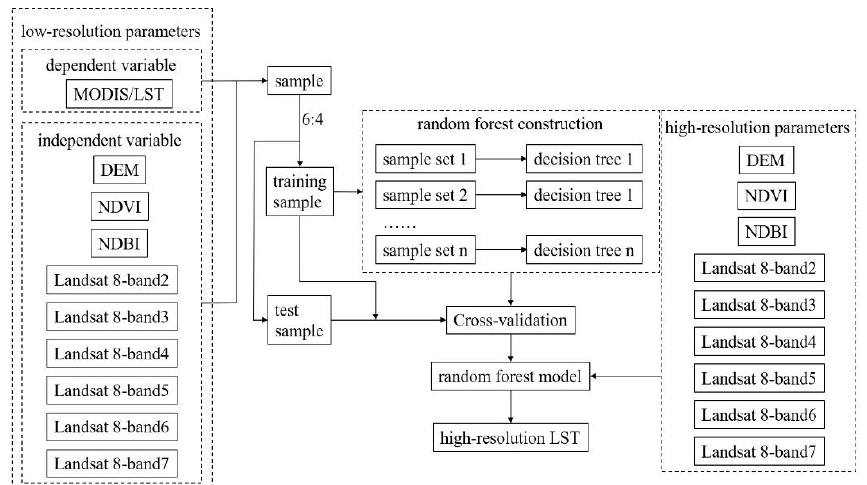
Figure 3. Building process of the random forest (RF) model.